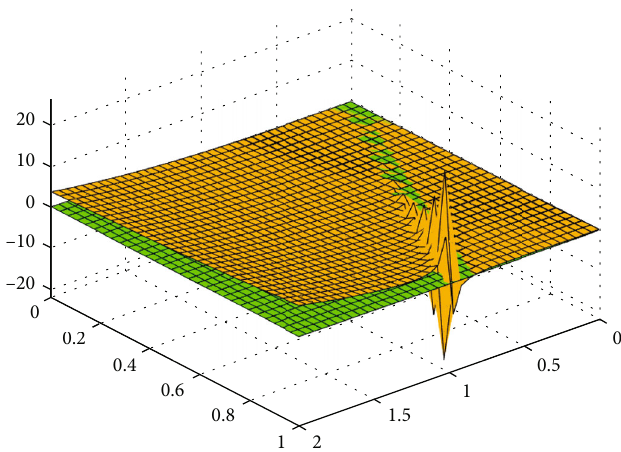
Figure 1: Three-dimensional illustration of the error and error bounds for (43).